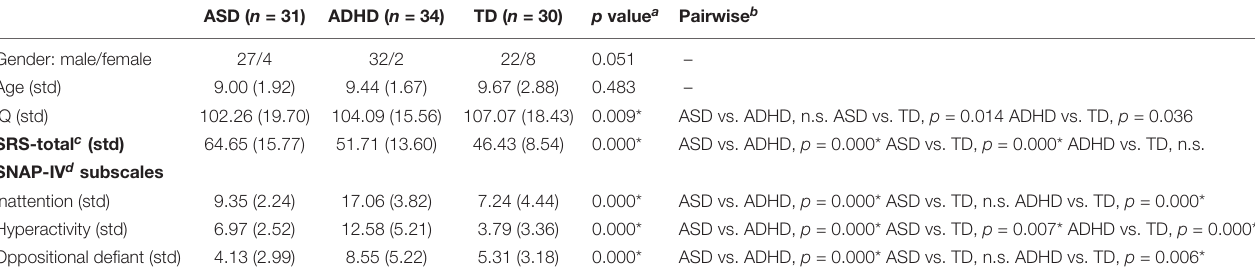
TABLE 2 | The demographic and clinical characteristics of all participants.